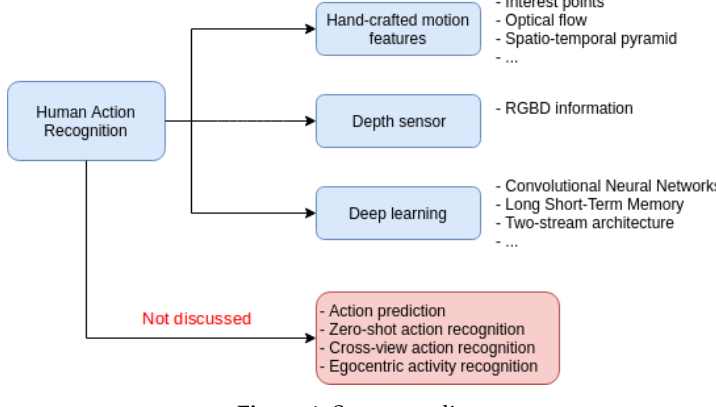
Figure 1. Summary